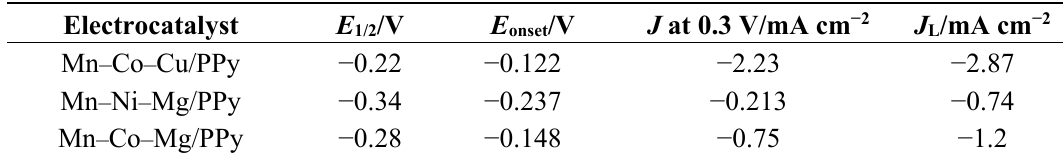
Figure 2. ( A , B , C ) RDE voltammograms recorded with Mn–Co–Cu/PPy, Mn–Ni–Mg/PPy and Mn–Co–Mg/PPy electrocatalysts in N 2 - and O 2 -saturated 0.1 KOH solution at 5 mV s − 1 and different RDE rotation rates (see Panel A). ( D , E , F ) Corresponding Koutecky-Levich plots at the indicated electrode potentials. ( G , H , I ) Tafel plots from ORR cyclovoltammetric curves recorded at 1400 rpm. Table 1. ORR electrocatalytic parameters for Mn–X–Y/PPy composites from voltammograms recorded in 0.1 M KOH with an RDE at 1400